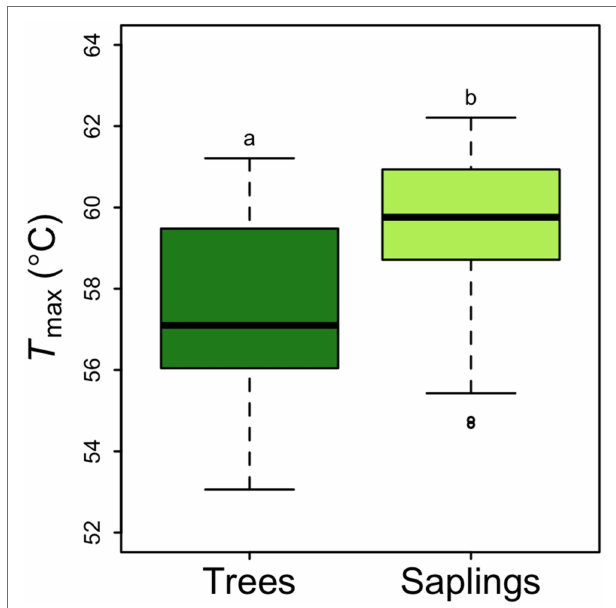
FIGURE 5 | Picea glauca T max (the leaf temperature corresponding to the maximum rate of respiration), as a function of tree size at the FTE in Alaska. Boxplot represent the median and the first and third quartiles. Whiskers delimit the range for each group, with outliers falling outside 1.5 times the interquartile range marked by points. Significant differences between groups are marked by different letters ( p < 0.05). Dark green box = trees ≥ 10 cm DBH, light green box = saplings 5–10 cm DBH. n =